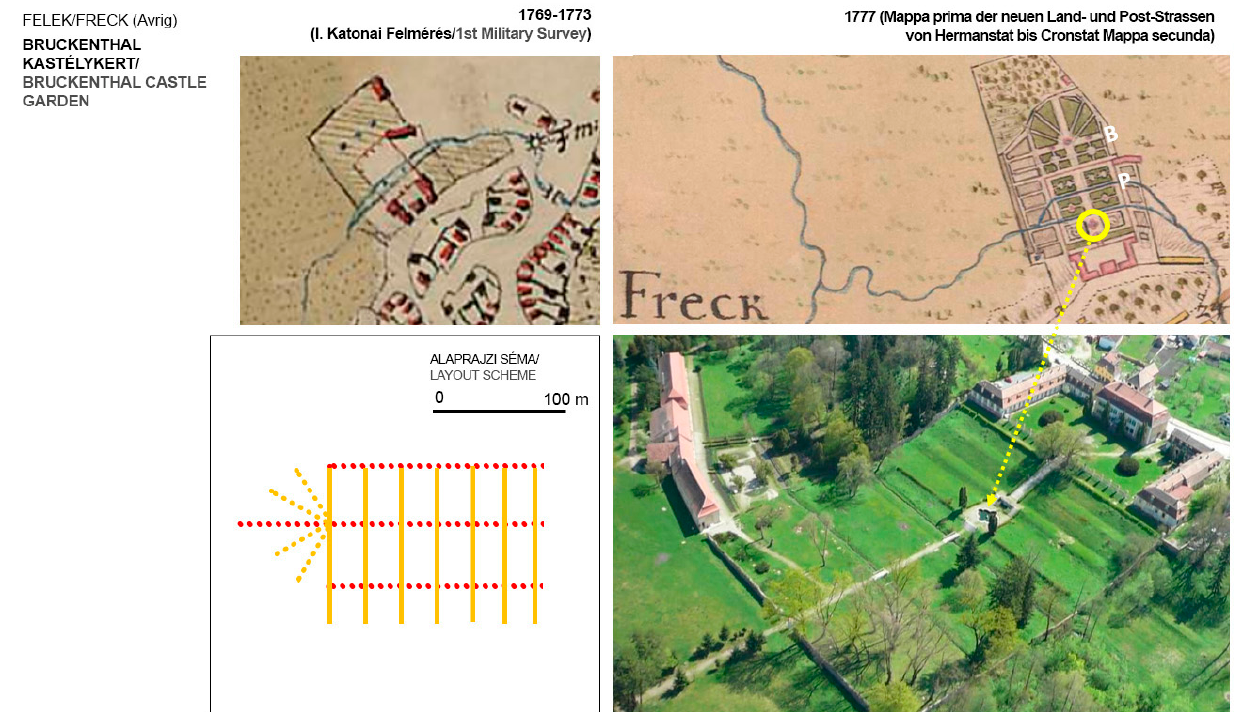
Figure 4. Map-based analysis of the mixed-layout Baroque garden in Felek.